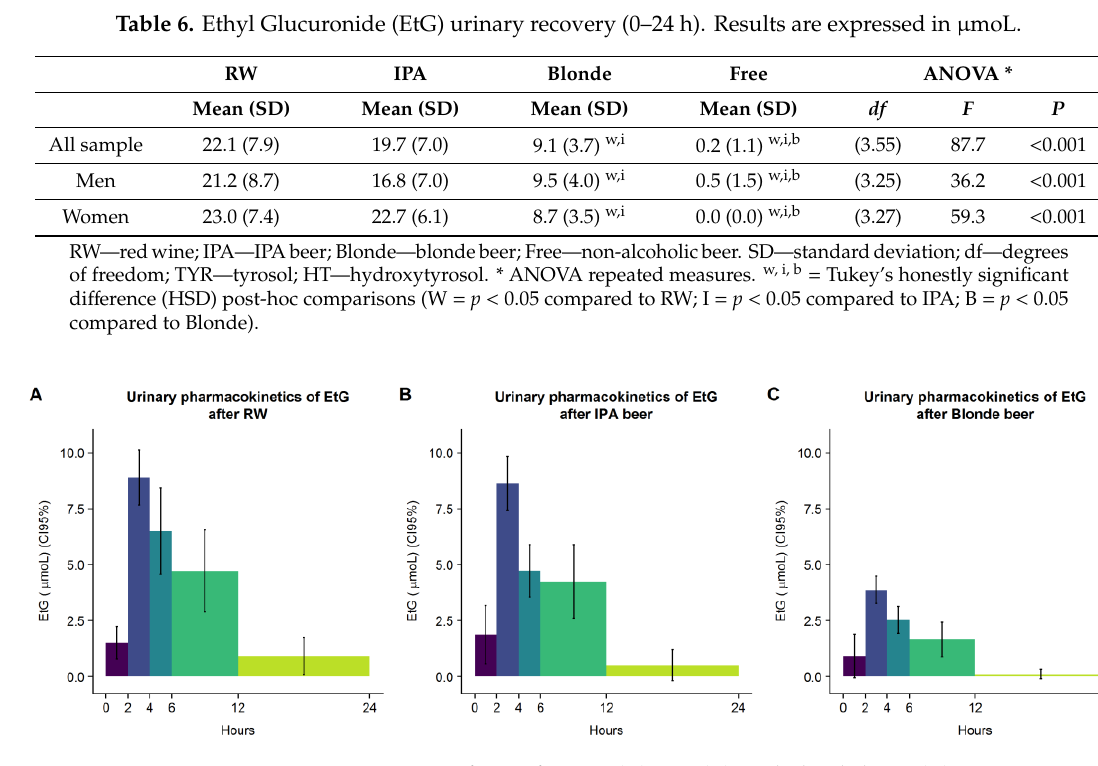
Figure 4. Urinary recovery of EtG after RW ( A ), IPA ( B ), and Blonde beers ( C ).